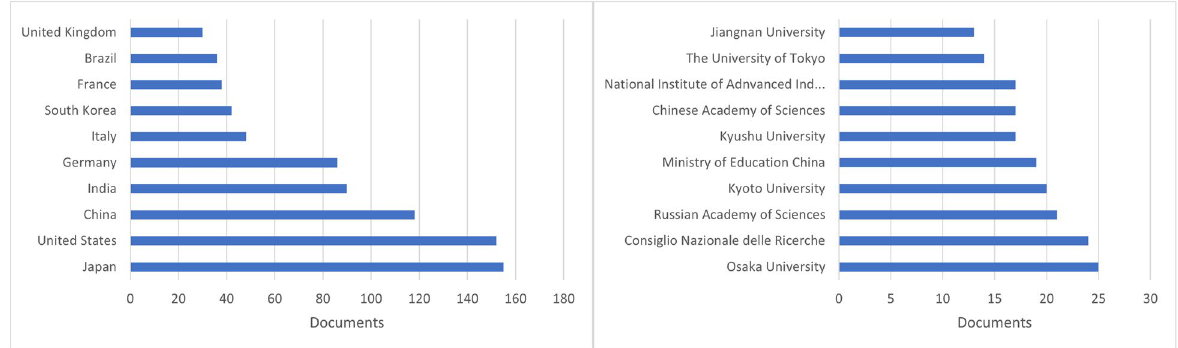
Fig. 5 Number of publications per country and top research institutions on thermostable enzyme research based on the Scopus